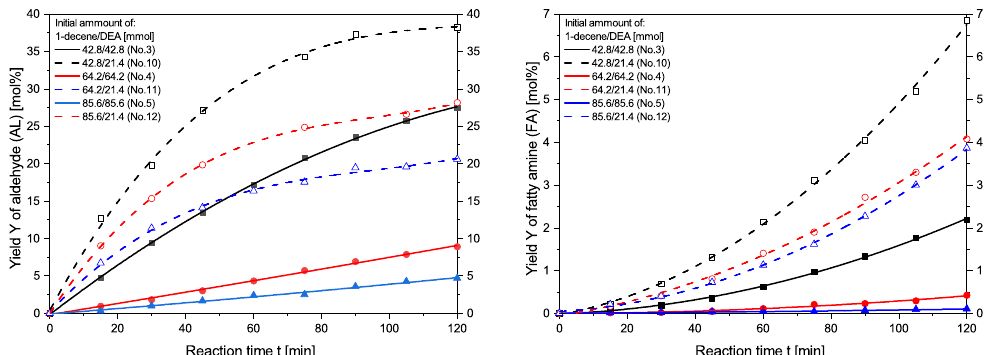
Figure 5. Comparison of aldehyde production ( left ) and fatty amine production ( right ) depending on initial concentrations of 1-decene and diethylamine. Reaction conditions: T=120 ◦ C, p=30bar H 2 /CO (2:1), 0.23mol% Rh, 0.92mol% SX, 12g organic phase (1-decene + dodecane), 12g water, 8wt% Marlophen NP8, 1wt% Na 2 SO 4 , 1200rpm,